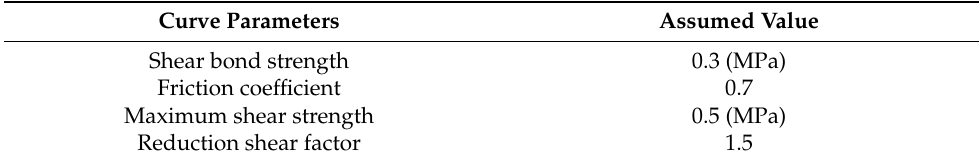
Table 3. Parameters of the shear strut implemented in the masonry model. Curve Parameters